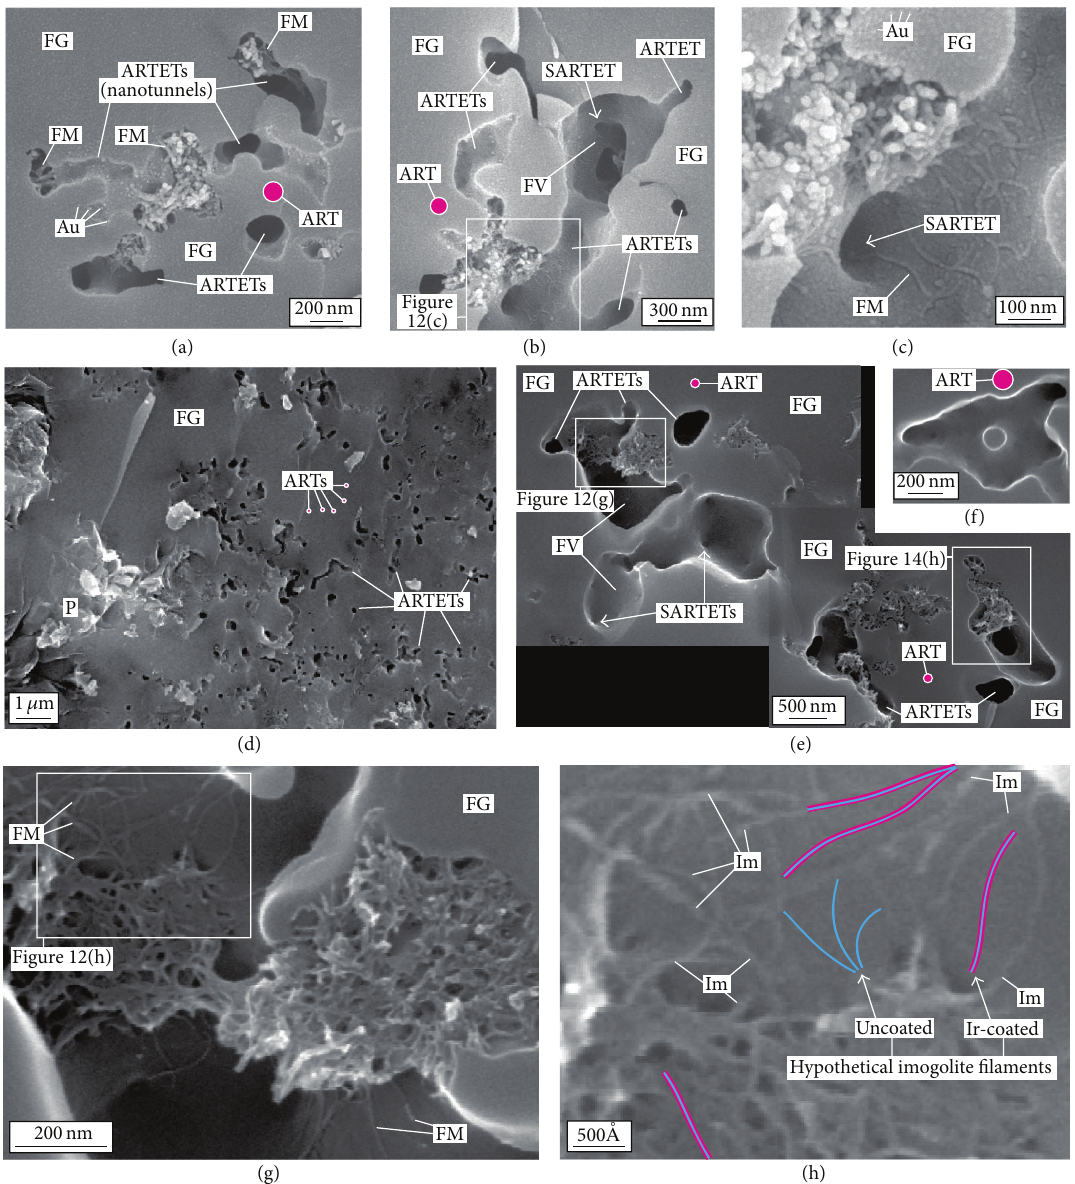
Figure 12: High resolution SEM (secondary electron) images of alpha-recoil track etch-tunnels (ARTETs) at the glass-palagonite interface (as observed on freshly fractured surfaces of basaltic glass “chip samples” from DSDP-418A-75-3[120–123] ). (a–c) Representative close-up images of typical ARTETs found at the glass-palagonite interface. Note the meandering, branching nature of the etch-tunnels and the occurrence of FM within them, and note that tunnel diameters are about the same size as a typical alpha-recoil track ( ∼ 120nm pink dots labelled “ART”). Other features include “pockmarks” that represent new side-tunnels (SARTETs), and flare-out voids (interpreted as etch-tunnelling of locally denseregionsofARTsorasARTETsaffectedbyprolonged“overetching” ± pressuresolution).(d)Overviewimage,showingatypicalregionof the glass-palagonite interface where abundant ARTETs occur, which are being encroached upon and overprinted by palagonite. (e) Overview of a region where numerous ARTETs, FVs, and SARTETs occur. (f) A region where an ARTET forms an etched-out “loop.” (g) Close-up from (e), highlighting abundant FM lining tunnel walls and draping/bridging across tunnel void spaces. (h) Close-up from (g). For comparison, several hypothetical imogolite filaments are drawn to scale (in blue) (i.e., 20 ˚A wide, the exact thickness of a single strand of imogolite), some of which also depict the 20 ˚A thick coating of iridium (magenta). Note the identical thickness of these hypothetical, iridium-coated imogolite filaments and the real nanofilaments imaged by SEM. ART: alpha-recoil track; ARTETs: alpha-recoil track etch-tunnels; Au: granules of gold sputtering; FG: fresh basaltic glass; FM: filamentous material; FV: flare-out voids; Im: imogolite; P: palagonite; SARTETs:“starting” alpha- recoil track